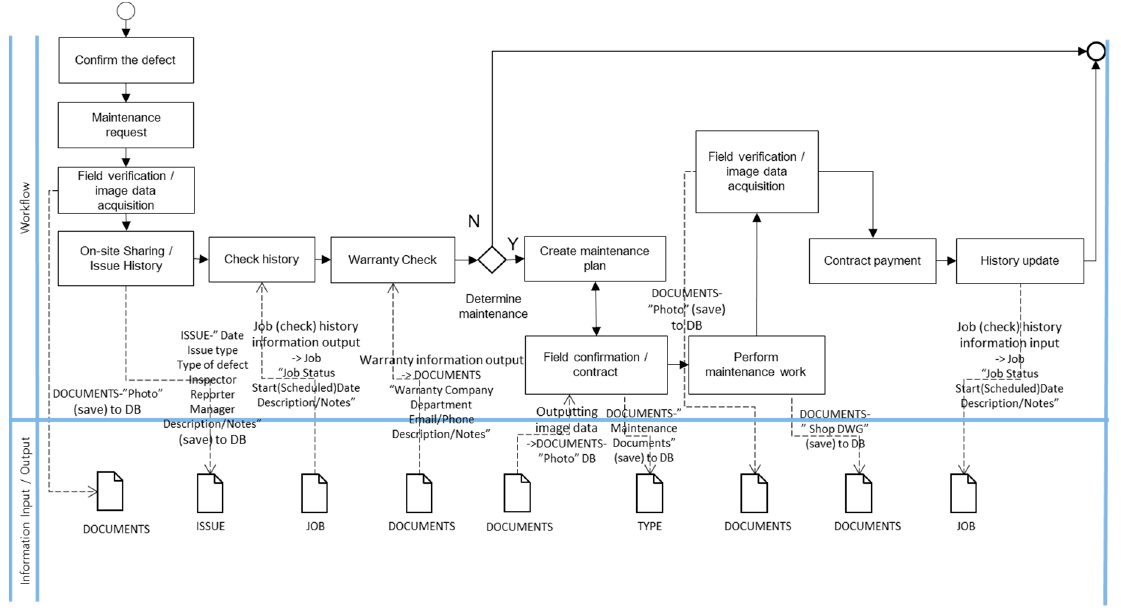
Figure 8. Defect reporting BPMN.